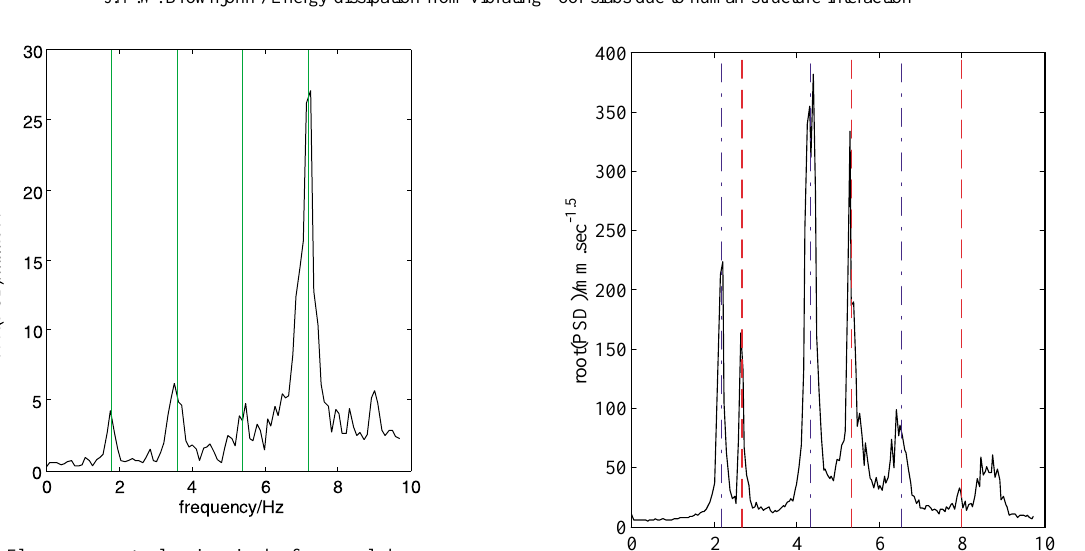
Fig. 10. Floor response to slow jumping by four people-bare floor.